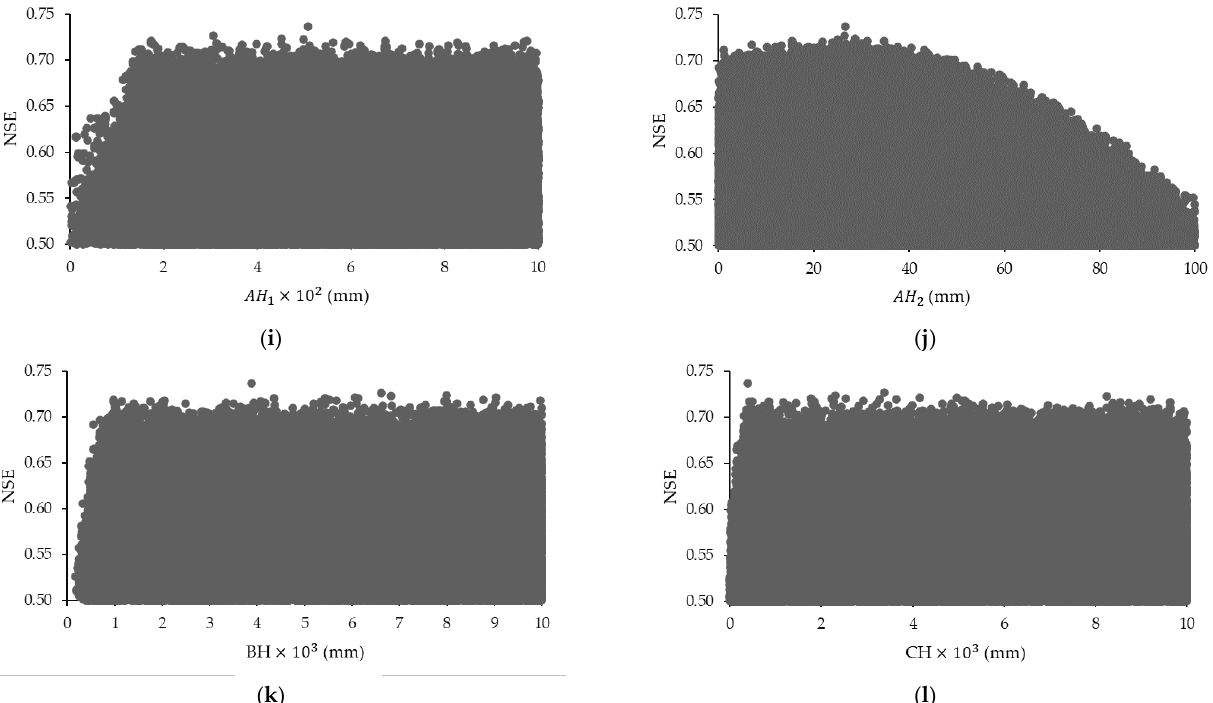
Figure 8. Scatter plots of NSE values versus the corresponding parameter values for tank model parameter sets that were got during model calibration. Each dot represents a separate parameter value from a given parameter set. Only simulations with an NSE value of at least 0.5 are shown. ( a ) A scatter plot of NSE versus values of parameter A 1 ; ( b ) A scatter plot of NSE versus values of parameter A 2 ; ( c ) A scatter plot of NSE versus values of parameter A 0 ; ( d ) A scatter plot of NSE versus values of parameter B 1 ; ( e ) A scatter plot of NSE versus values of parameter B 0 ; ( f ) A scatter plot of NSE versus values of parameter C 1 ; ( g ) A scatter plot of NSE versus values of parameter C 0 ; ( h ) A scatter plot of NSE versus values of parameter D 1 ; ( i ) A scatter plot of NSE versus values of parameter AH 1 ; ( j ) A scatter plot of NSE versus values of parameter AH 2 ; ( k ) A scatter plot of NSE versus values of parameter B H ; ( l ) A scatter plot of NSE versus values of parameter CH.